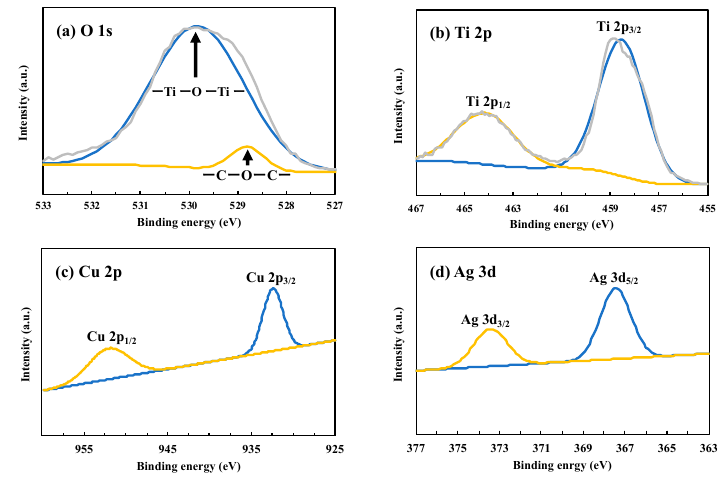
Figure 3. XPS spectra of ( a ) O 1s, ( b ) Ti 2p, ( c ) Cu 2p, and ( d ) Ag 3d over CuAg/TiO 2 .